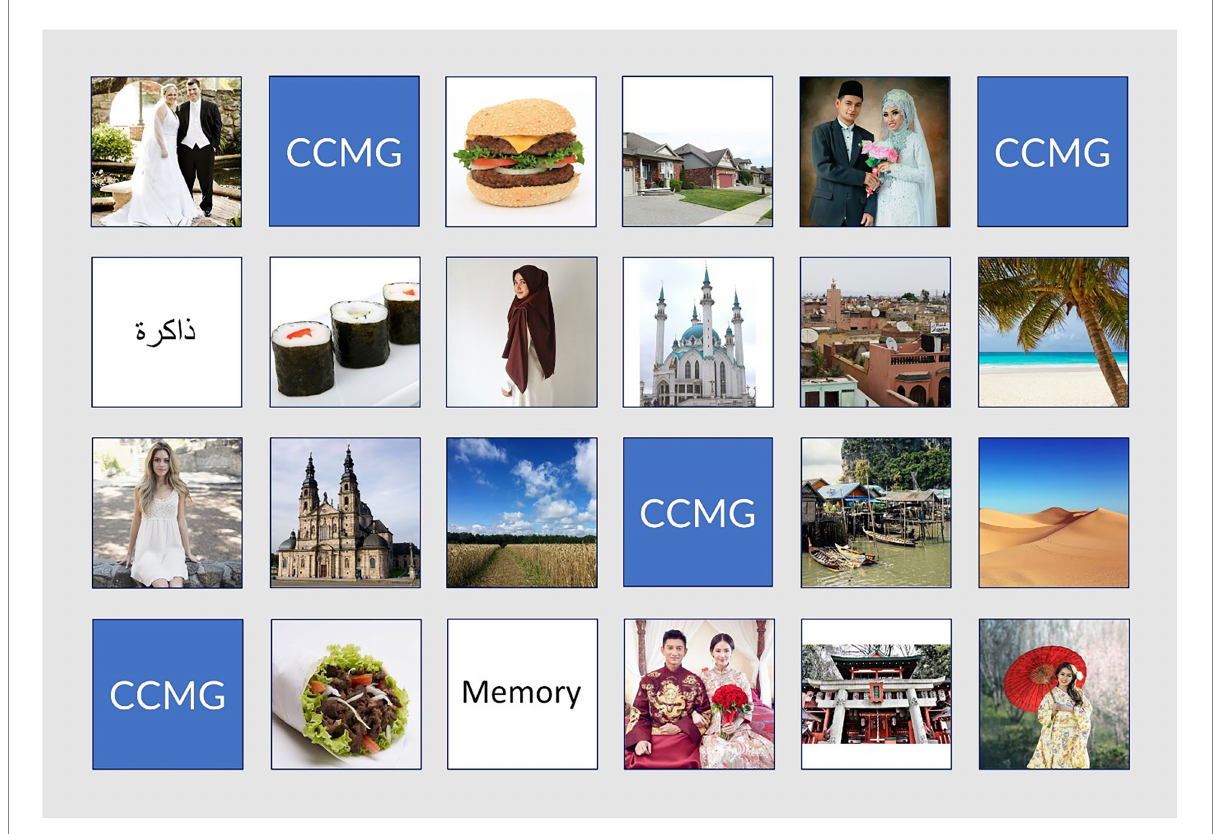
FIGURE 1 Example interface of the online CCMG. The different images indicate the uncovered matches and the blue tiles with CCMG-symbols indicate (at that given point) non-uncovered/face down items. The script match is not fully uncovered yet. All the images included in the CCMG were obtained from public databases, namely www.pixabay.com and